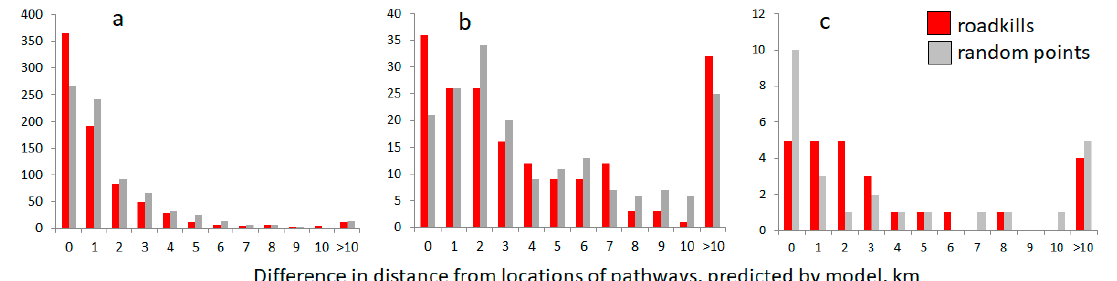
Figure 7. Distribution of distances between model-predicted pathways and the roadkill locations compared to distances between pathways and random locations for roe deer ( a ), wild boar ( b ) and red deer ( c ).